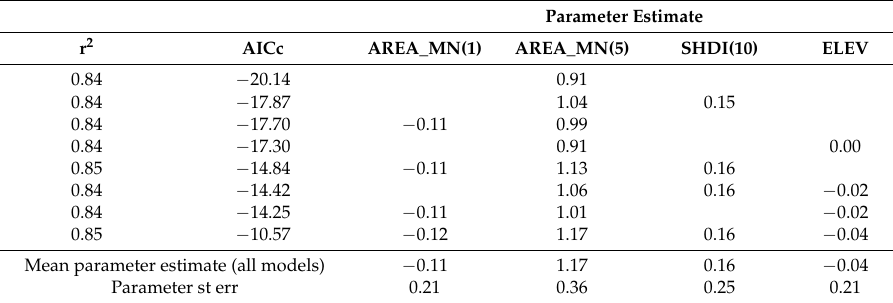
Table 5. Parameter estimates and AIC scores for the top eight models used to predict average D. variabilis density among 13 sites in Virginia. This suite of variables had a maximum condition index of 5.5 and no variables had a variance inflation factor higher than